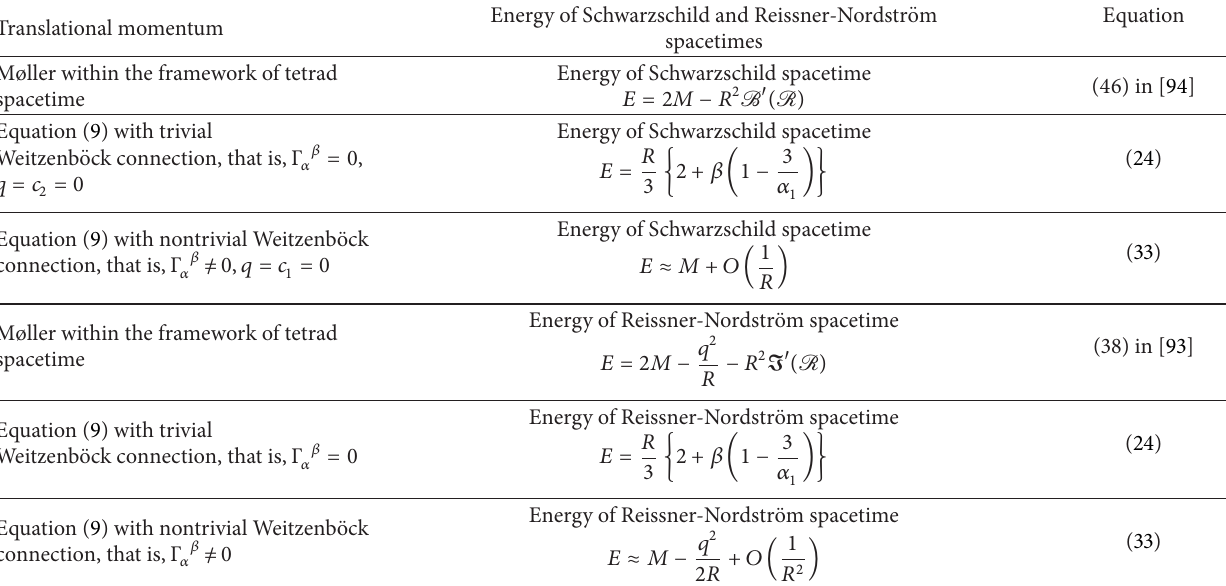
Table 2: Comparison between the results of energy using different translational momentum. Energy of Schwarzschild and Reissner-Nordstr¨om Translational momentum spacetimes